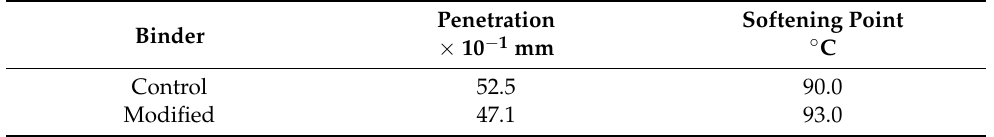
Table 2. Properties of control and modified binders.